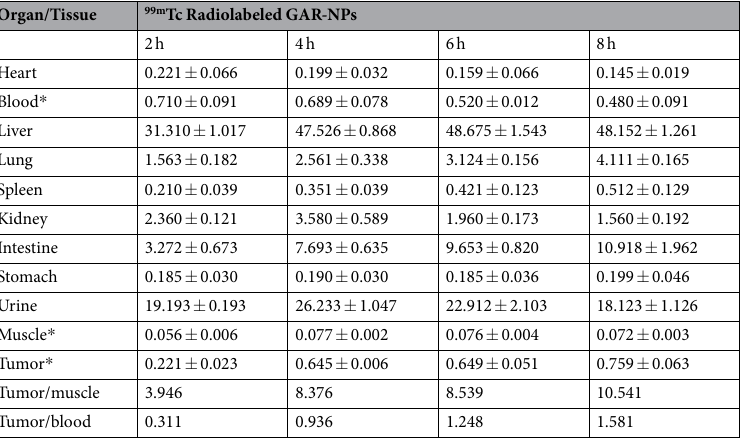
Table 2. Results of biodistribution studies of 99m Tc labelled GAR-NPs in B16F10 tumor-bearing mice at 2, 4, 6 and 8 h post injection time periods. Results are expressed in percentage injected dose per organ/tissue (each value is the mean ± SEM of five animals per group). * Percent injected dose per gram.